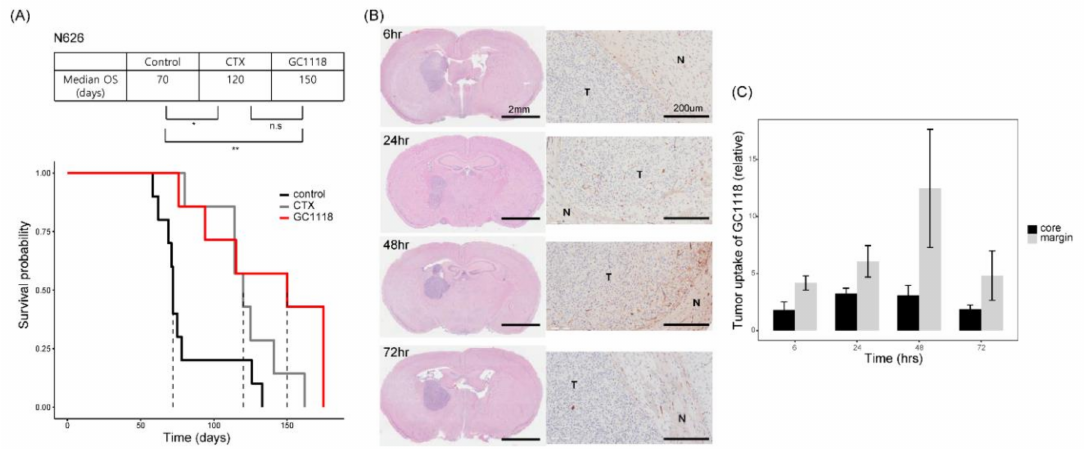
Figure 4. GC1118 can cross the blood–brain barrier and reach the GBM tumor core. ( A ) Kaplan–Meier survival plots of intracranial xenograft models treated with GC1118, cetuximab, or PBS alone (two-sided Log-rank test; non-significant, p > 0.05; *, p ≤ 0.05; **, p ≤ 0.01); ( B ) in vivo distribution analysis of GC1118 within the brain. Intracranial xenografts were sacrificed at several time points